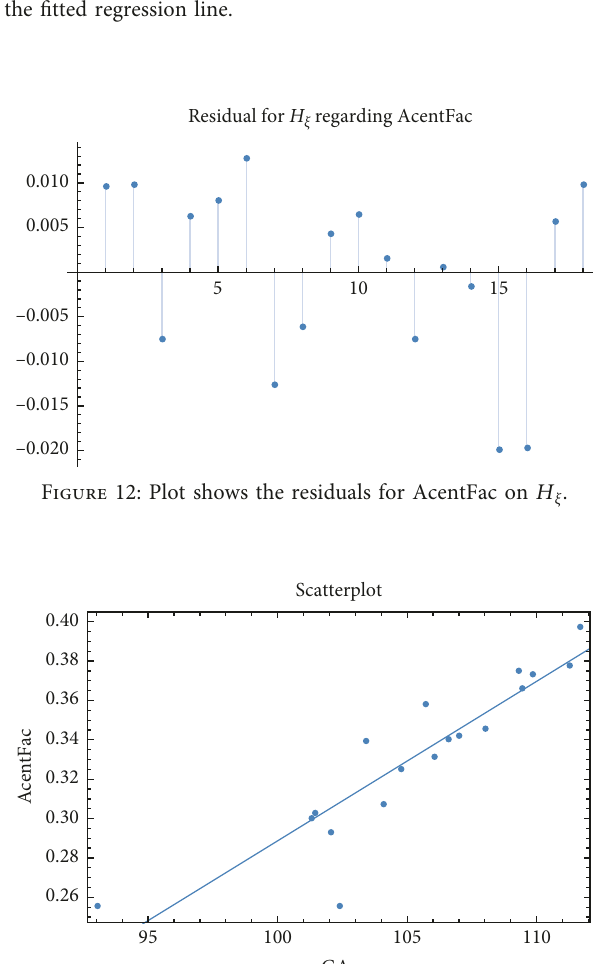
superimposed by ξ